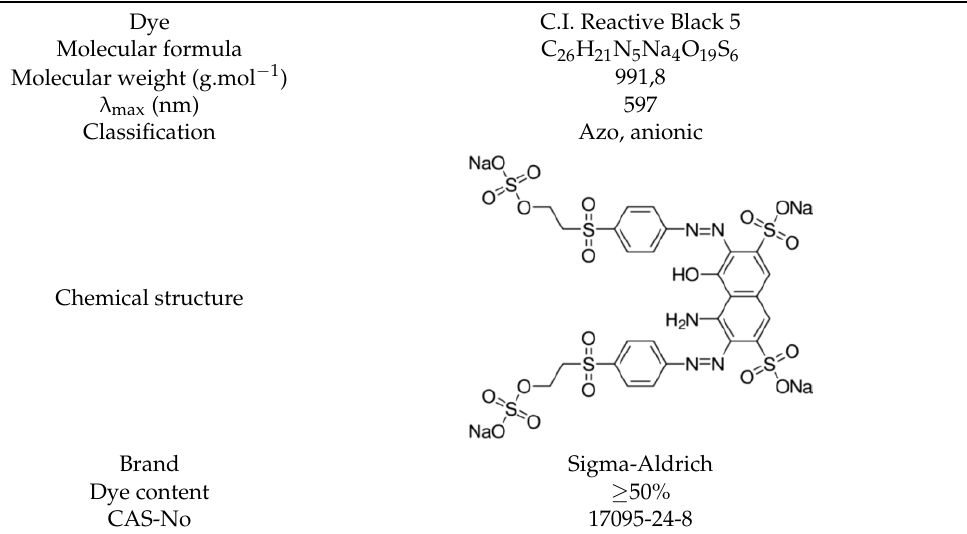
Table 2. Characteristics of Remazol Black B-RB5 (adapted from [40]).